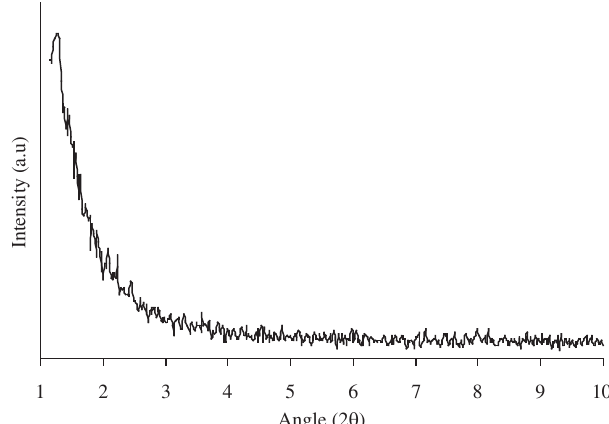
Figure 1. X ray diffraction pattern of as synthesized sample prepared from Tween 80 and Span 80 surfactant mixture.